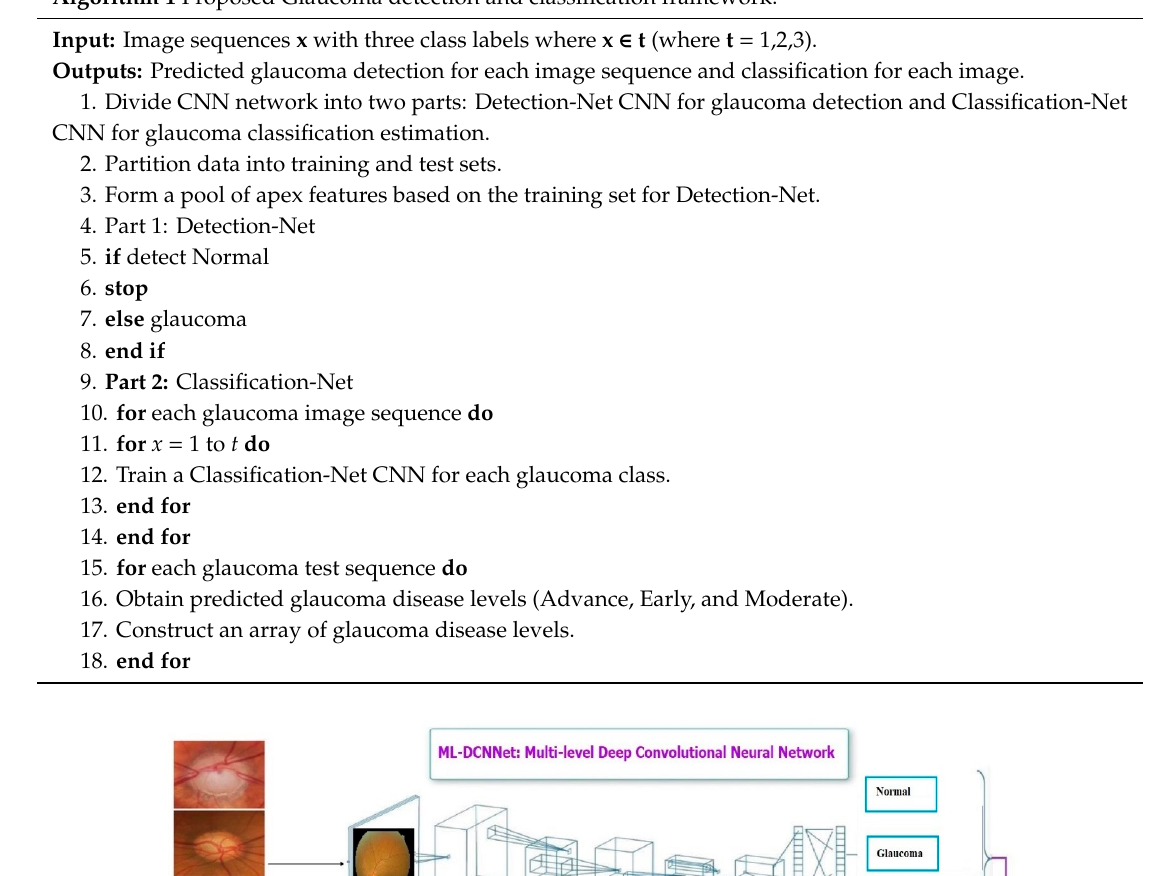
Algorithm 1 Proposed Glaucoma detection and classification framework.